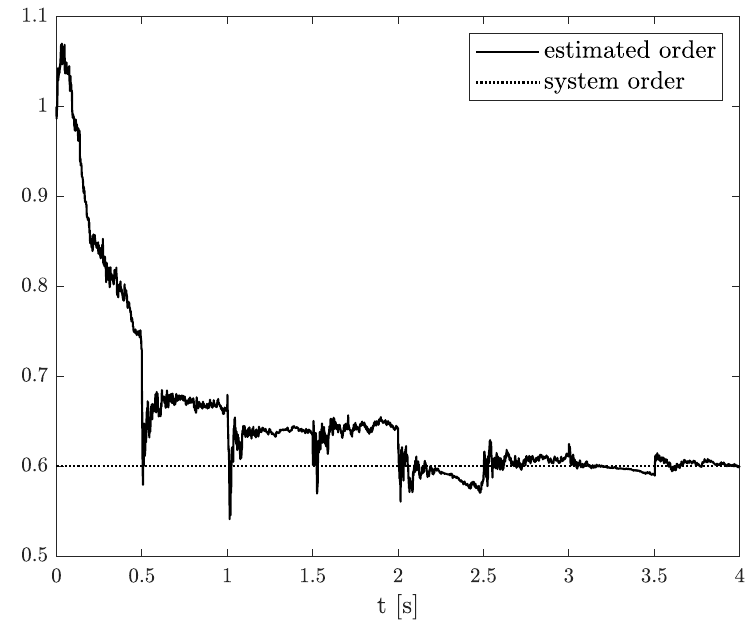
Figure 9. Original and estimated order from Example